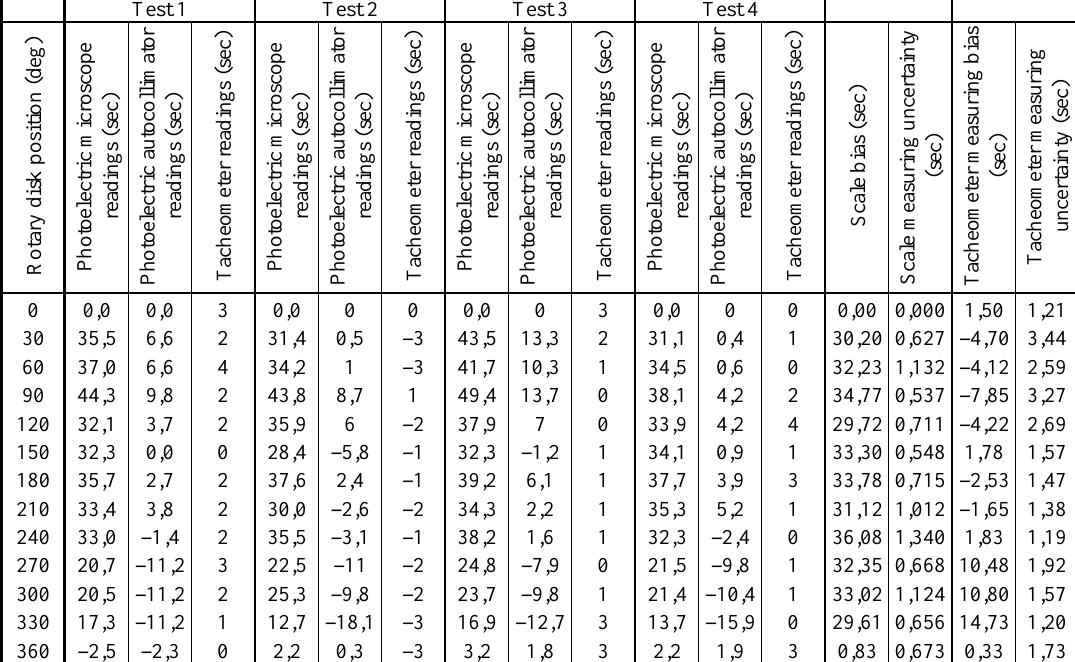
Table 3. Preliminary test